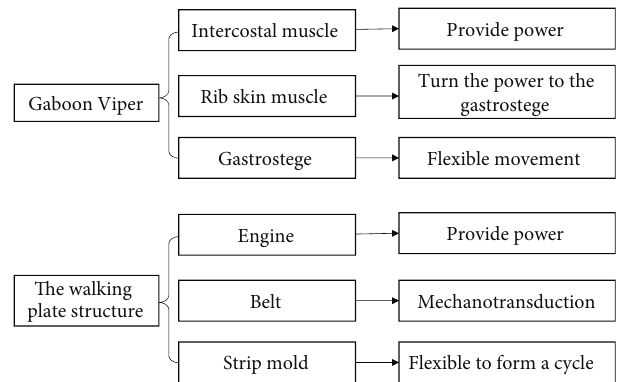
Figure 10: The schematic diagram of the biotechnology system transformation of the skewer-pushing structure.